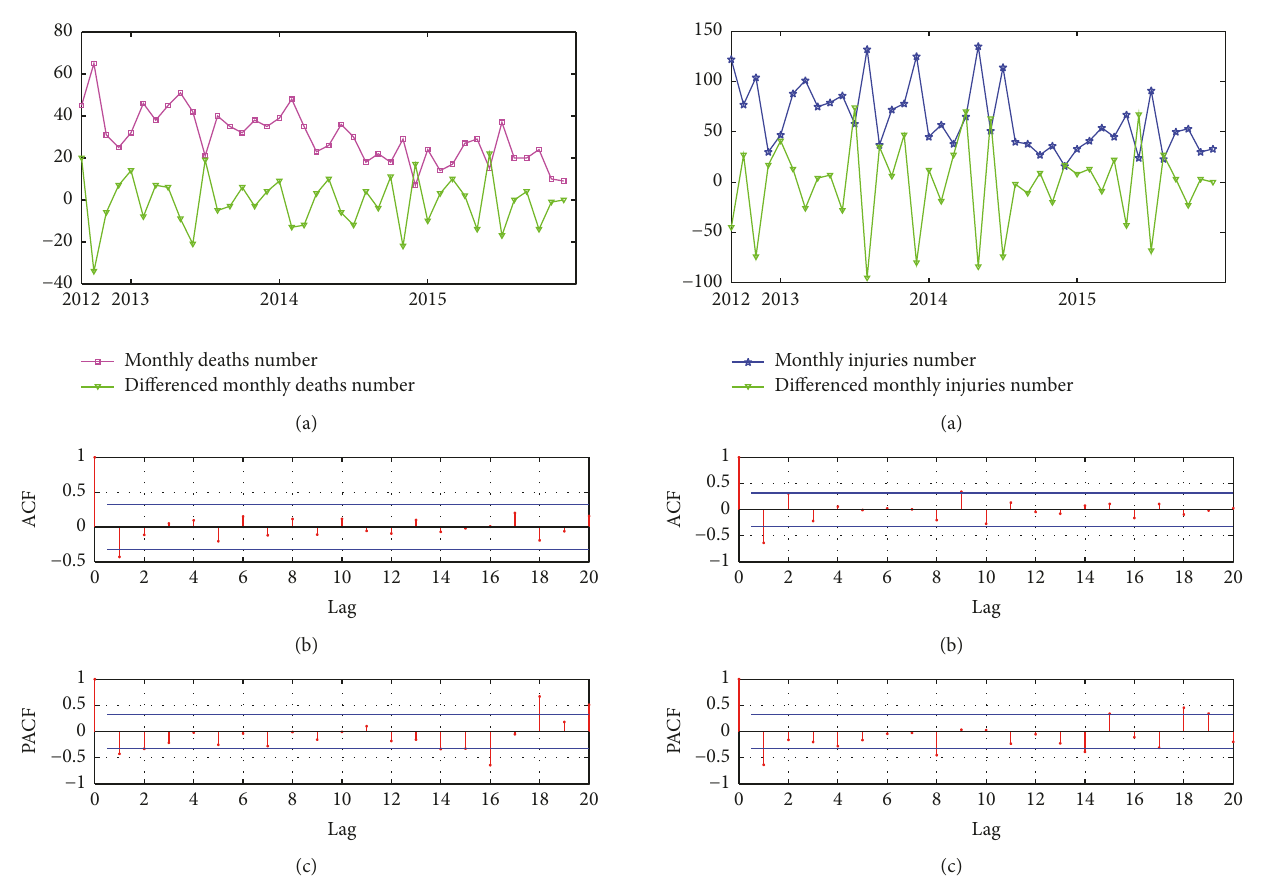
Figure 3: (a) Monthly number of deaths is plotted against its first differenced series, acf (b) and pacf (c) plots for the first difference in monthly number of deaths.